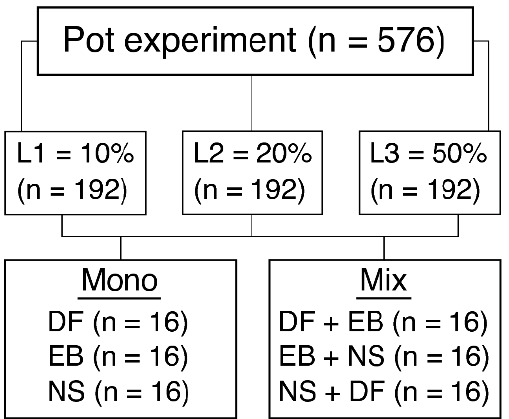
Figure 1. Experimental design. L1, L2, and L3 represent light availability levels. DF—Douglas fir, EB—European beech, NS—Norway spruce. The combinations and the number of replicates presented under the “Mono” and “Mix” categories were the same across all light levels (L1–L3).